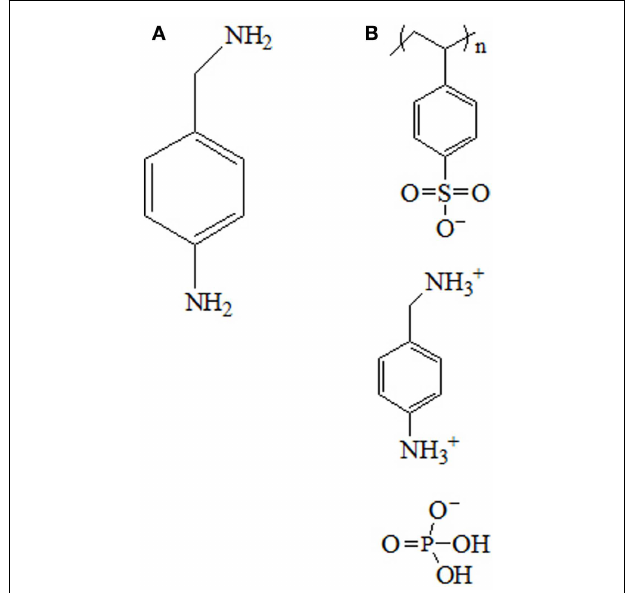
FIGURE 1 | Chemical structures of (A)ABA molecule and (B) PSSA/ABA/PA composite membrane